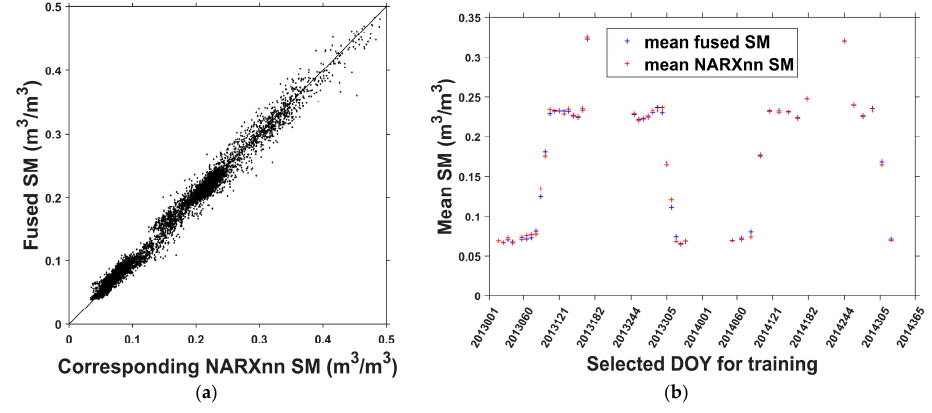
Figure 5. Comparison of the corresponding NARXnn SM and the fused SM during the training period. The scatter plots show the correlation among and differences between the gridded values, and the temporal plots show the extension and consistency of their mean values: ( a ) scatter plot (gridded values); and ( b ) temporal plot (mean values).